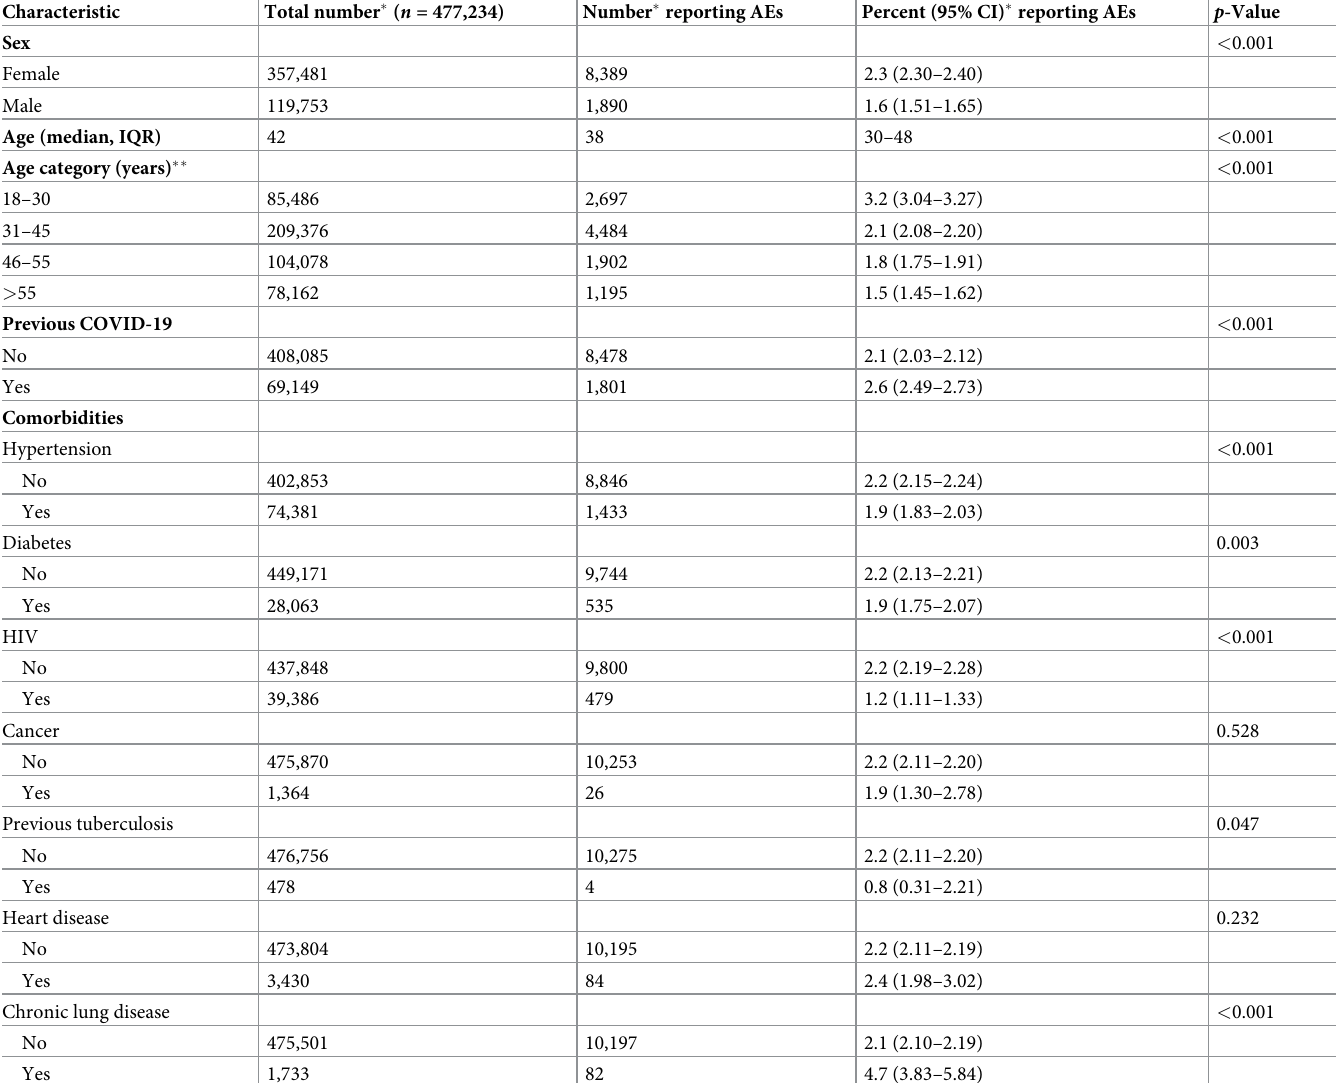
Table 1. Demographic AU : InTable 1 : pleasecheckthattheeditstothecolumnheadsandfootnotesareaccurate : Ifnot ; pleaseeditasnecessary : and clinical characteristics of Ad26.COV2.S vaccine recipients in the Sisonke study.